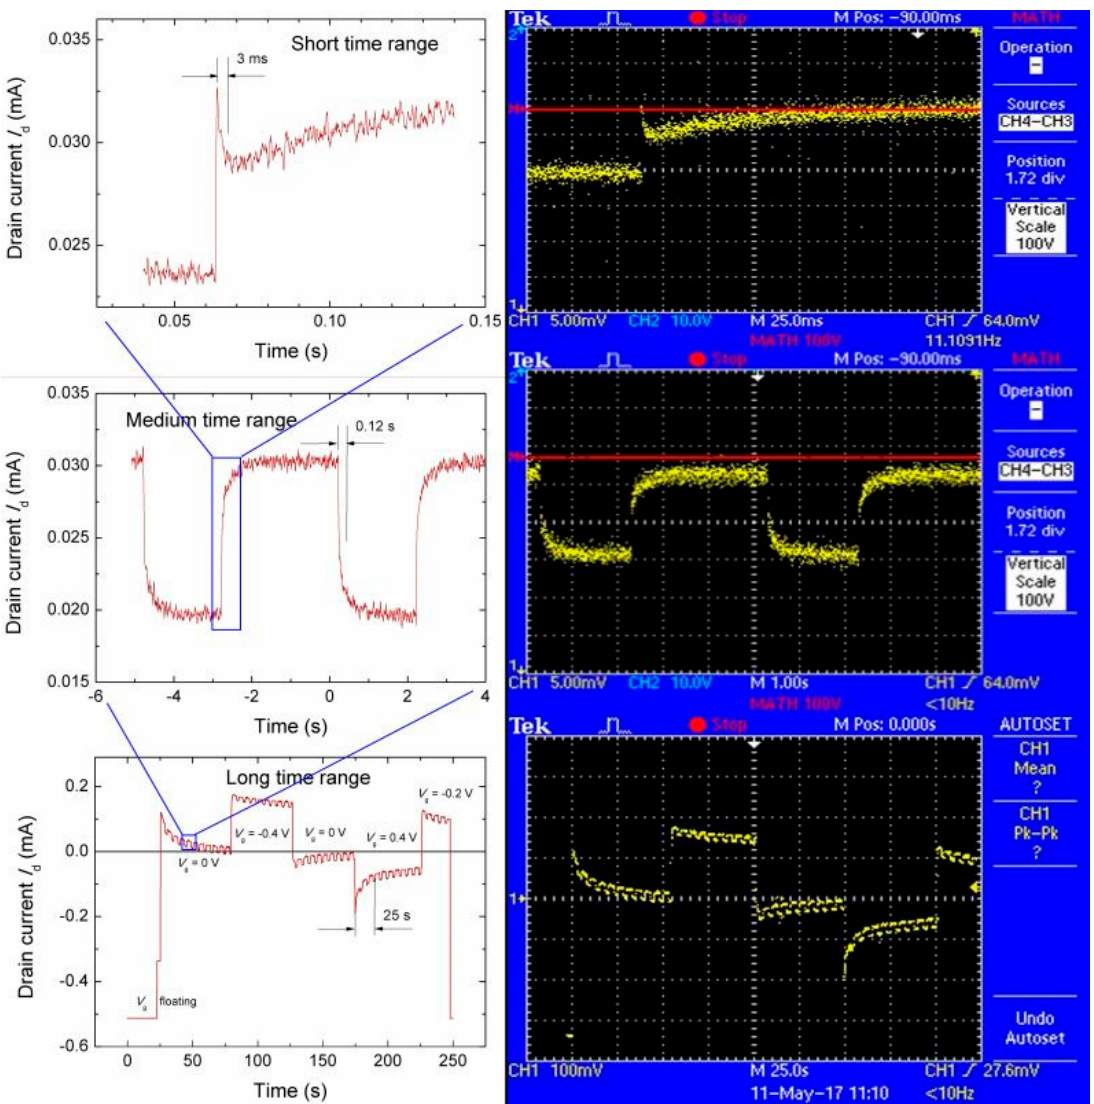
Figure 4. Response of output voltage of the preamplifier - I / V converter (calibrated in drain current units) on the gate input voltage at V ds = − 0.735 V and variable gate voltage V gs modulated by rectangular pulses of voltage 10 mV pp and a 5 s period.